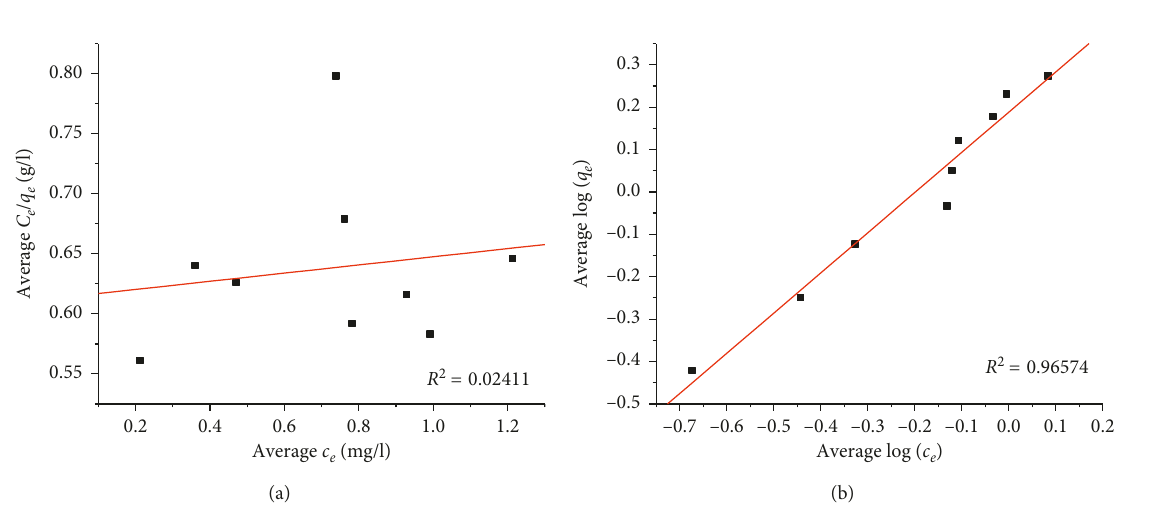
Figure 8: (a) Langmuir isotherm and (b) Freundlich isotherm for MB adsorption on to CESP.